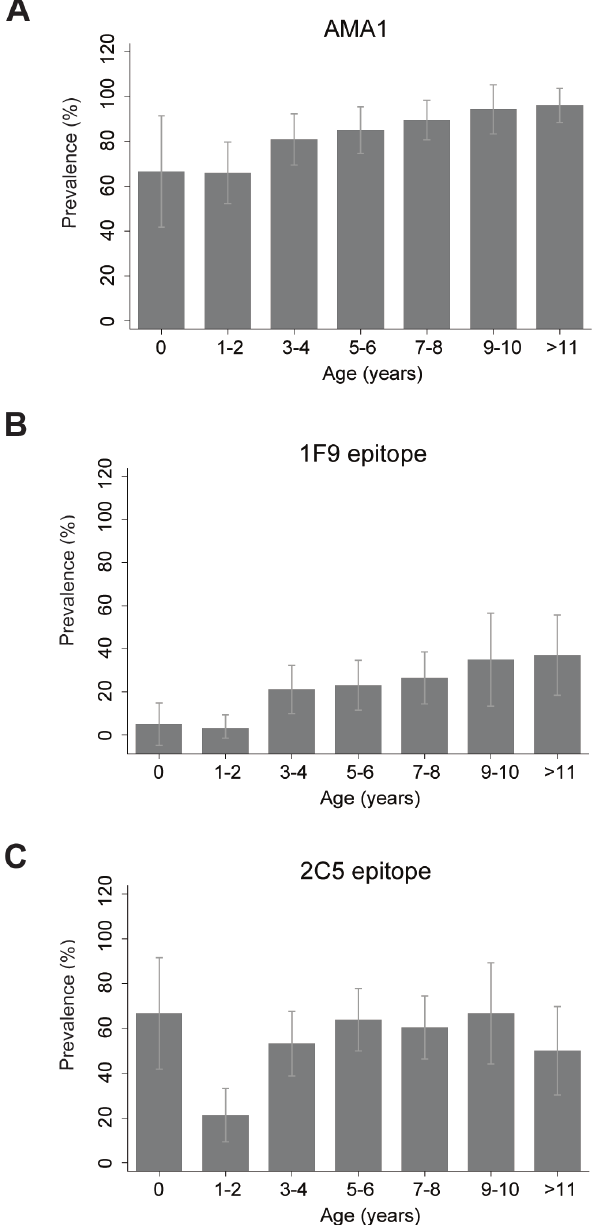
Figure 1. Prevalence of antibodies to AMA1 or specific epitopes by age group in the Chonyi cohort. Antibodies to recombinant AMA1 protein were tested by standard ELISA. Antibodies to specific AMA1 epitopes were measured by assessing the ability of human serum antibodies to inhibit the binding of monoclonal antibodies 1F9 and 2C5 in competition ELISA. ( A ) IgG to recombinant AMA1 (P , 0.001), ( B ) inhibition of binding of mAb 1F9 epitope (P , 0.001), ( C ) inhibition of binding of mAb 2C5 (P=0.028). P values were calculated using the Chi square test for trend excluding age 0 ( , 1) years. Data represent the proportion of individuals with detectable IgG binding or inhibitory activity and error bars indicate 95% CI.